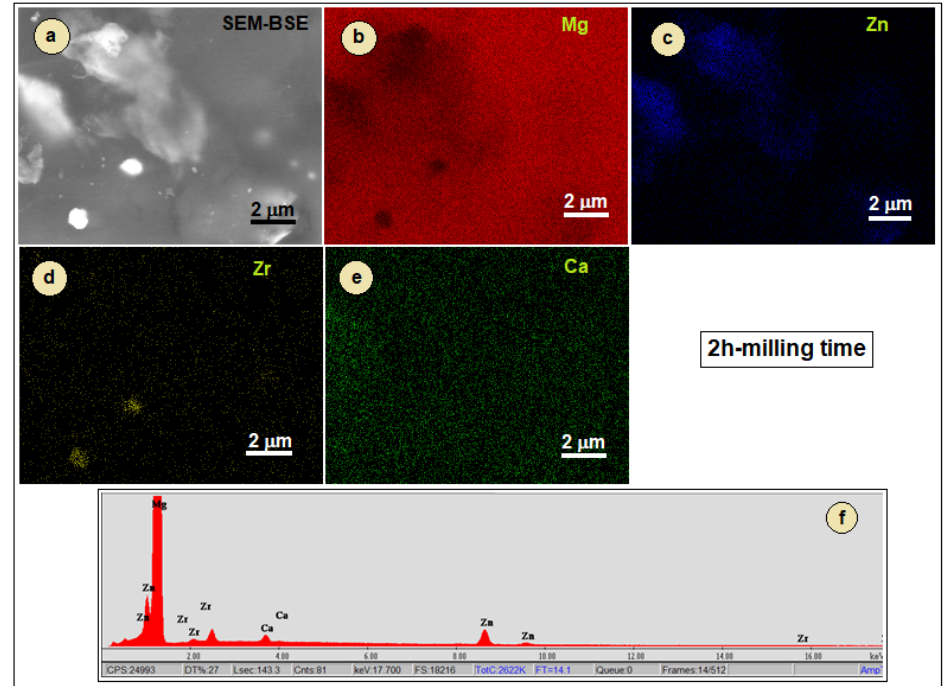
Figure 8. Distribution map of alloying elements for the powder-alloy processed by mechanical alloying at 2 h/300 rpm: ( a ) SEM image of the powder; ( b ) SEM-EDS distribution of Mg; ( c ) SEM-EDS distribution of Zn; ( d ) SEM-EDS distribution of Zr; ( e ) SEM-EDS distribution of Ca; ( f ) global EDS spectra. Table 3 indicates the calculated average chemical composition, resulting from EDS analysis, for all tested variants. The values presented are within those initially established for the study alloy. Due to the SEM-EDS technique limitations, the presences of O and other elements with a low atomic number (Z) were not quantified. Table 3. Average chemical compositions of the powder-alloy obtained by EDS analysis for all ap- plied variants of the mechanical alloying process. Milling Time